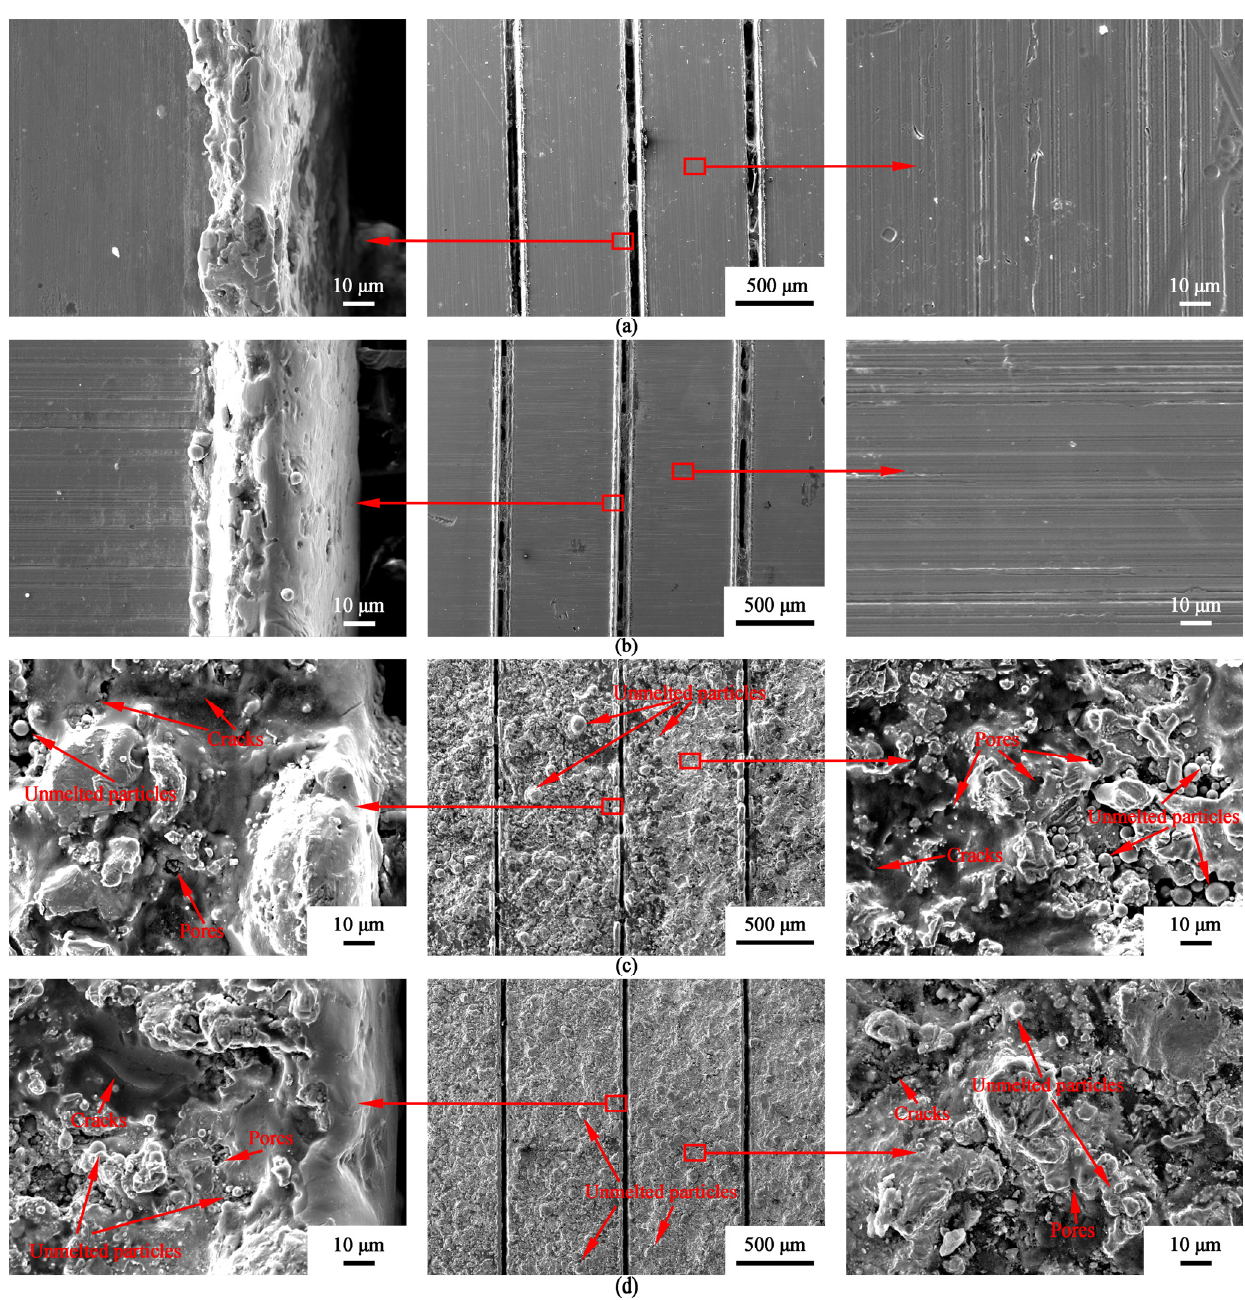
Figure 4. SEM images of specimen WJ ( a ), specimen RJ ( b ), specimen AJ ( c ) and specimen BJ ( d ).